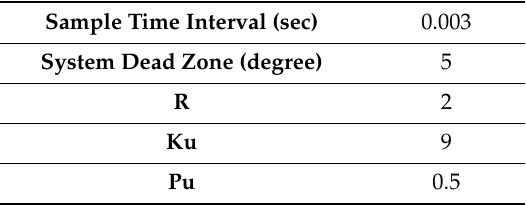
Table 6. System parameter